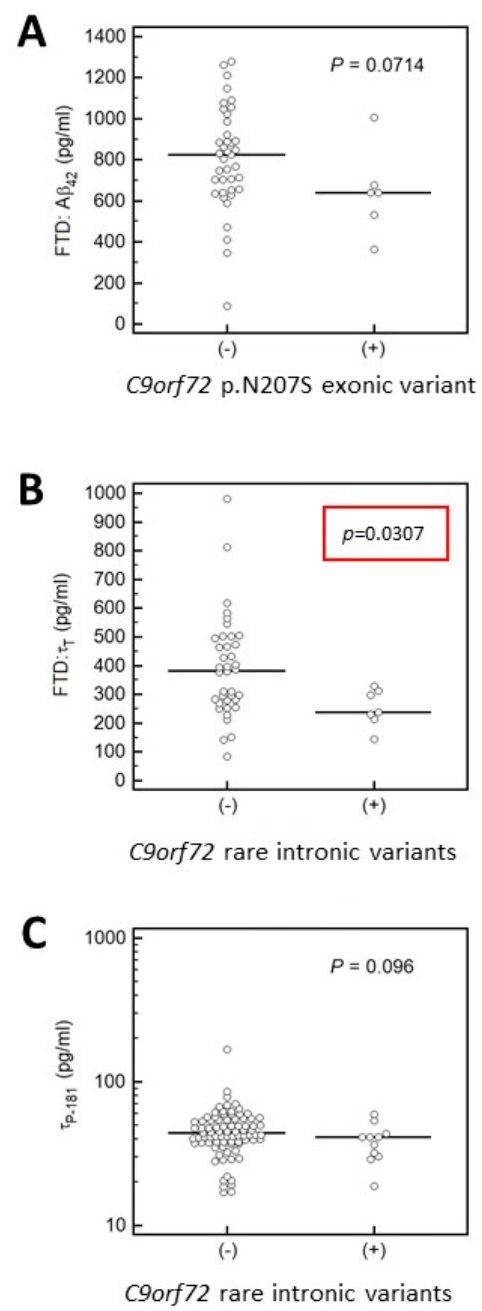
Figure 3. A β 42 , τ T and τ p-181 CSF levels in FTD, ALS and FTD/ALS patients carrying either the p.Asn207Ser (p.N207S) exonic C9orf72 variant ( A ) or the rare intronic C9orf72 variants ( B , C ). ( A ) Here